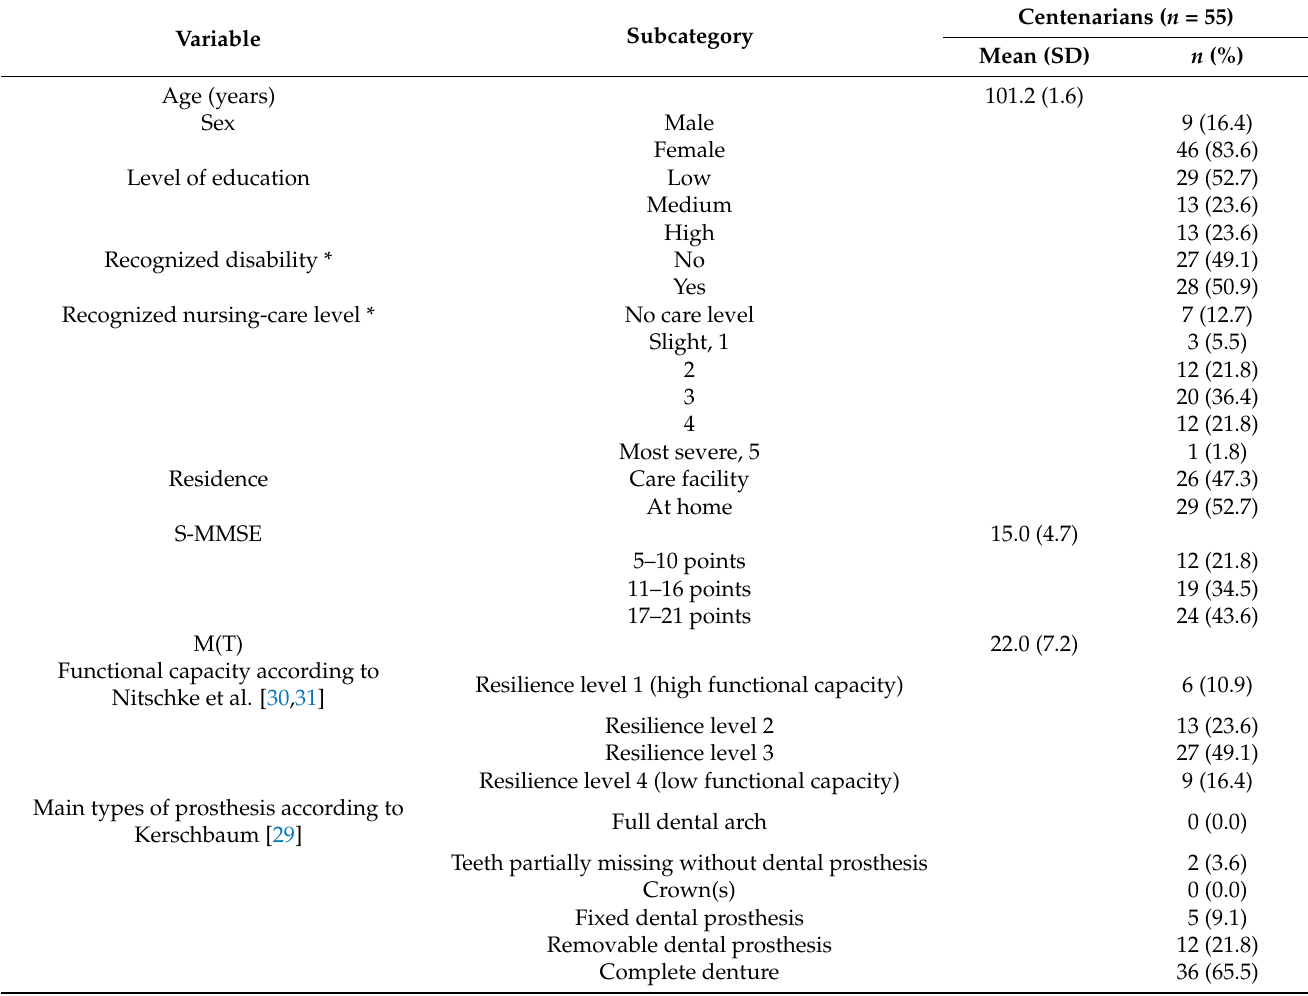
Table 1. Characteristics of the study